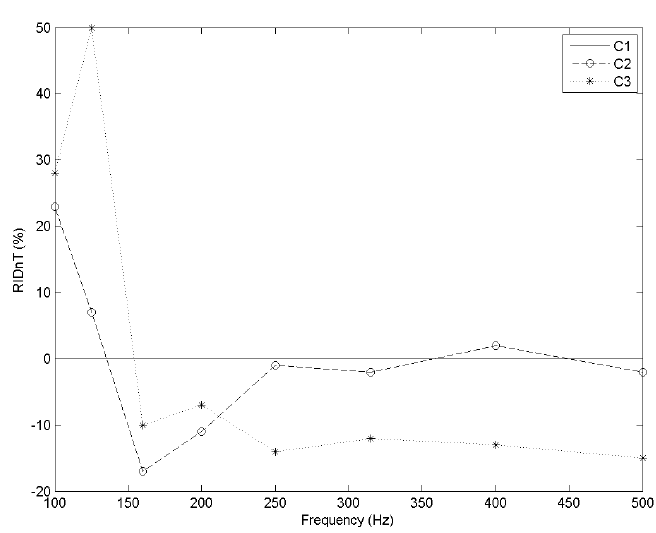
Figure 9. RID nT (%) vs. frequency (Hz) for each cell type. Frequency range 100–500 Hz.